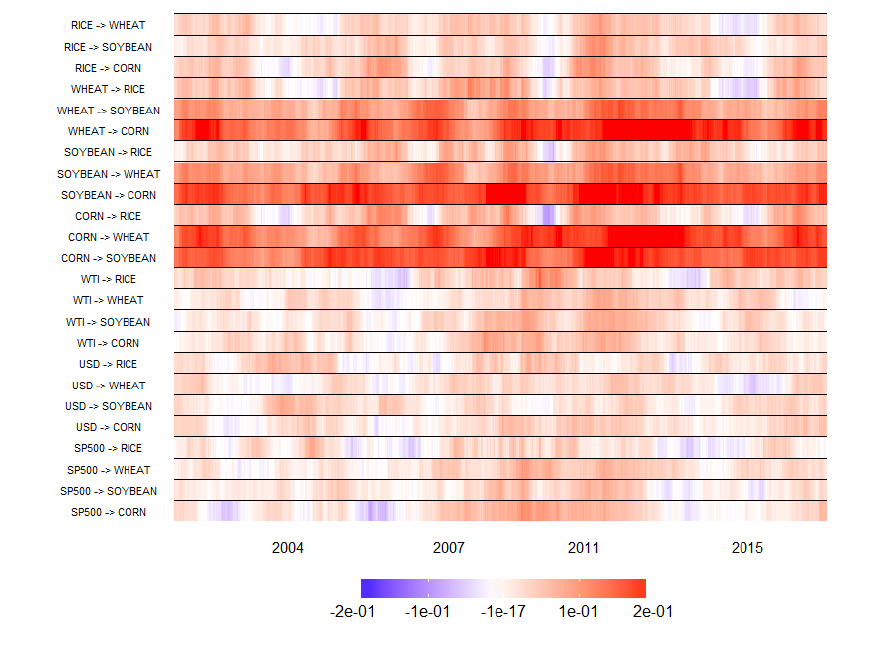
Figure 8A: The response of the food markets to shocks originating from other markets (the OLS